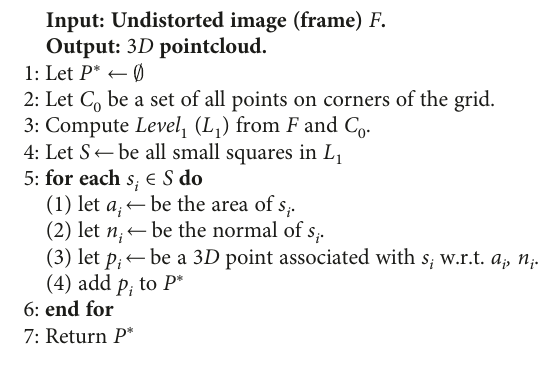
Algorithm 2: Initial 3D mapping using a